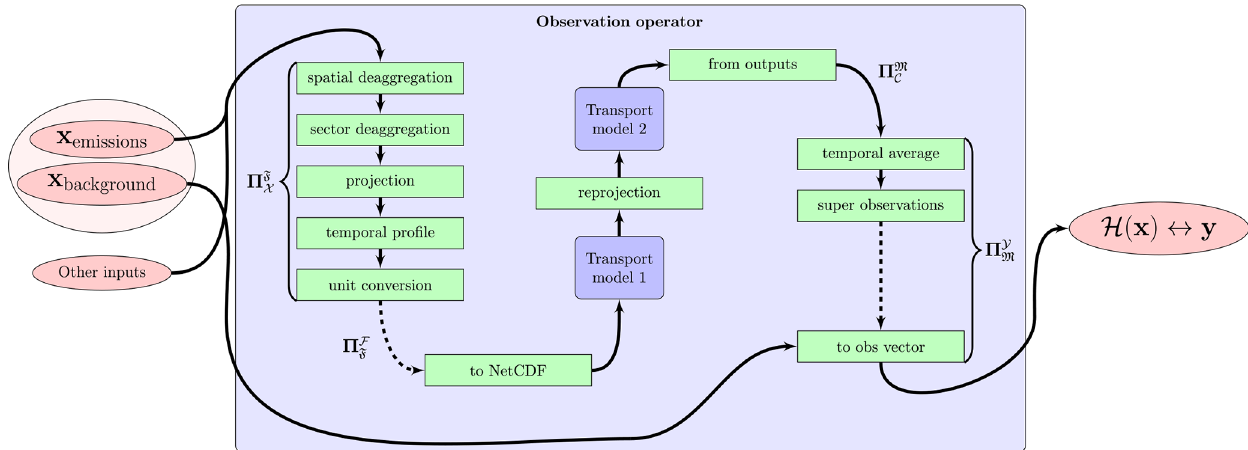
Figure 2. Observation operator structure. Emissions are processed from the target vector to generate model inputs, as well as other inputs, not optimized by the inversion; in this example, some background for the simulations is also optimized by the inversion and is added to simulations at the end of the pipeline just before stacking outputs to the observation vector format.